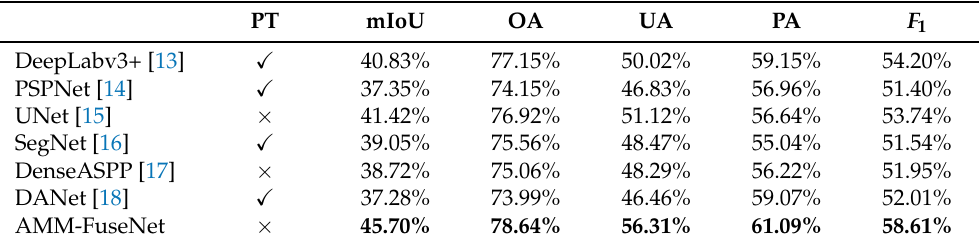
Table 7. Performance comparison for Hunan (Sentinel-2 and DEM) dataset. ( (cid:88) : pre-trained (PT) and × : not PT